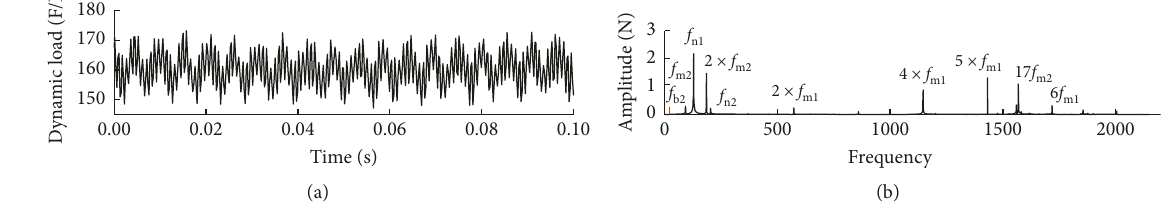
Figure 15: Bearing force with BTVS. (a) Dynamic load time history. (b) Dynamic load spectrum.